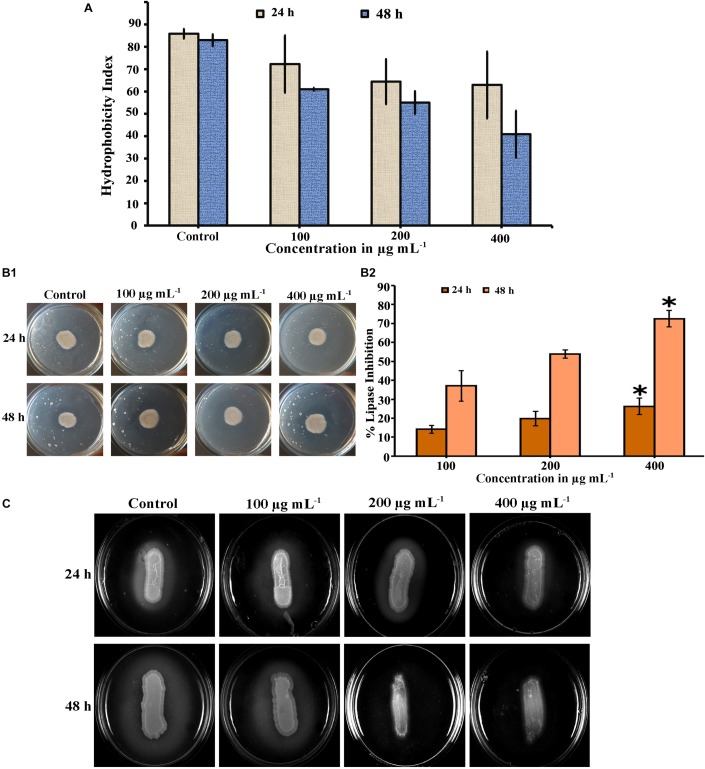
Inhibitory effect of PA on virulence factors of C. tropicalis. (A) Bar graph showing the reduction of cell surface hydrophobicity in PA-treated (100, 200, and 400 μg mL−1) C. tropicalis after 24 h and 48 h treatment. (B) Effect of PA at different concentrations (100–400 μg mL−1) on C. tropicalis lipase measured (i) quantitatively and (ii) qualitatively after 24 and 48 h of treatment. (C) Effect of PA on the extracellular protease production of C. tropicalis on BSA agar medium. The values are expressed as means and error bars indicate standard deviation of triplicates (n = 6). ✽p < 0.05, ✯p < 0.01 and p < 0.001, significantly different when compared with control.